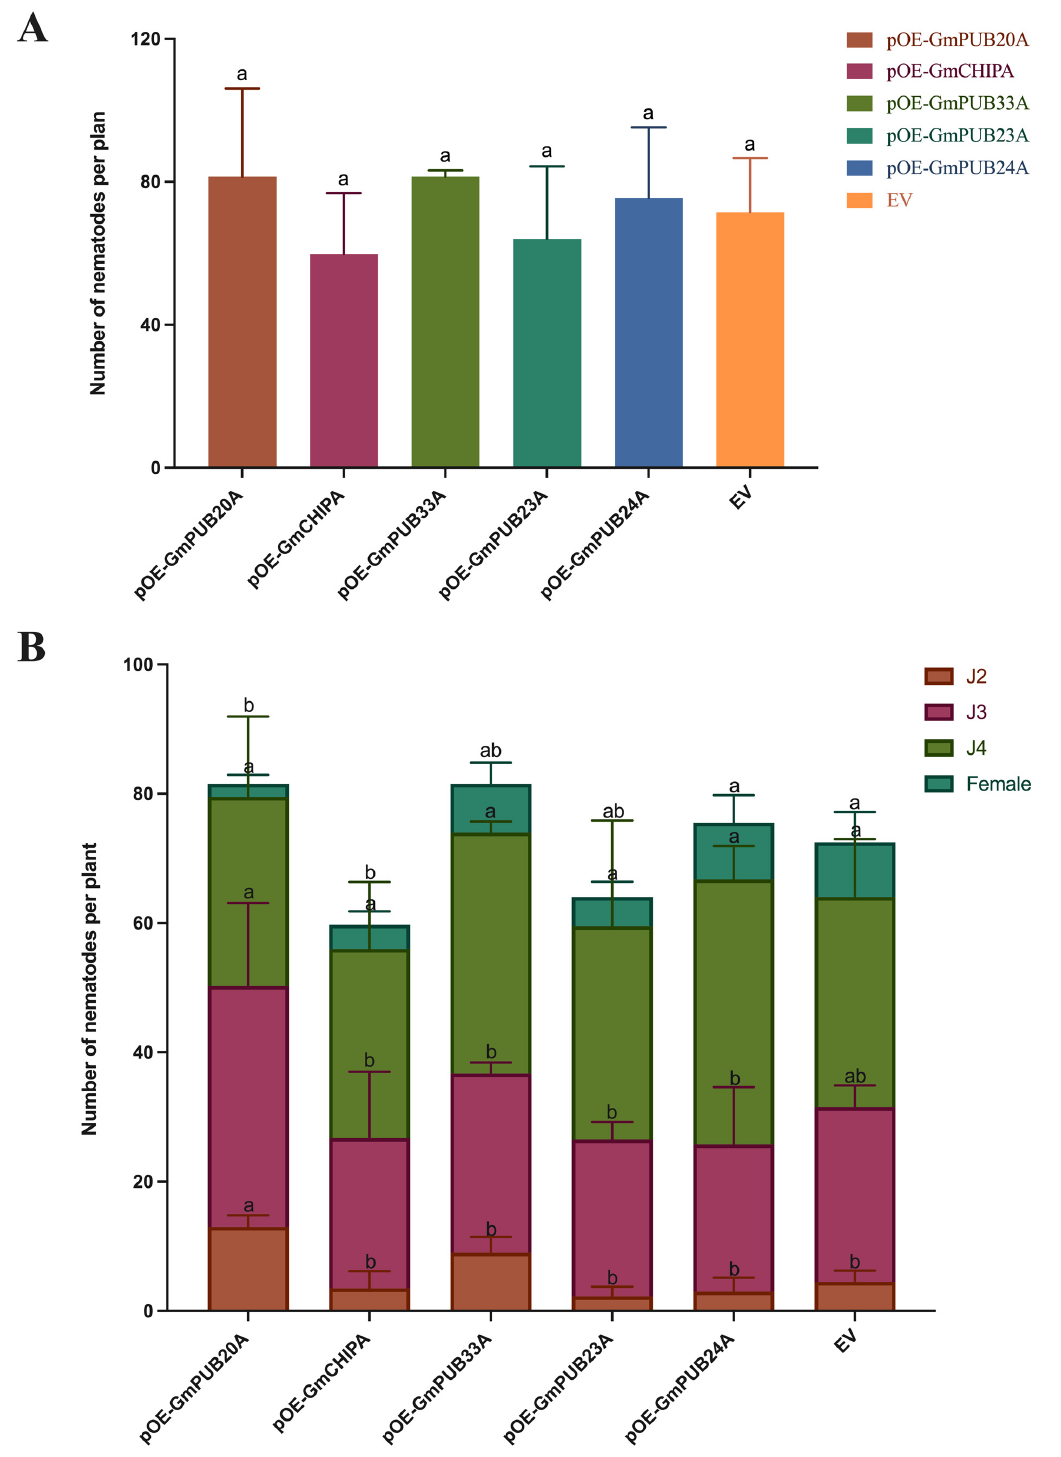
Figure 8. Number of nematodes in the five GmPUBs -overexpressed hairy roots. Note: ( A ), total number of nematodes per plant, ( B ), number of different stage nematodes per plant. One-way ANOVAs were applied in SPSS to analyze the difference in the number of nematodes in EV and other transgenic hairy roots, and the Holm–Sidak method was used to determine the statistical significance. Different characters mean significant differences found at p < 0.05